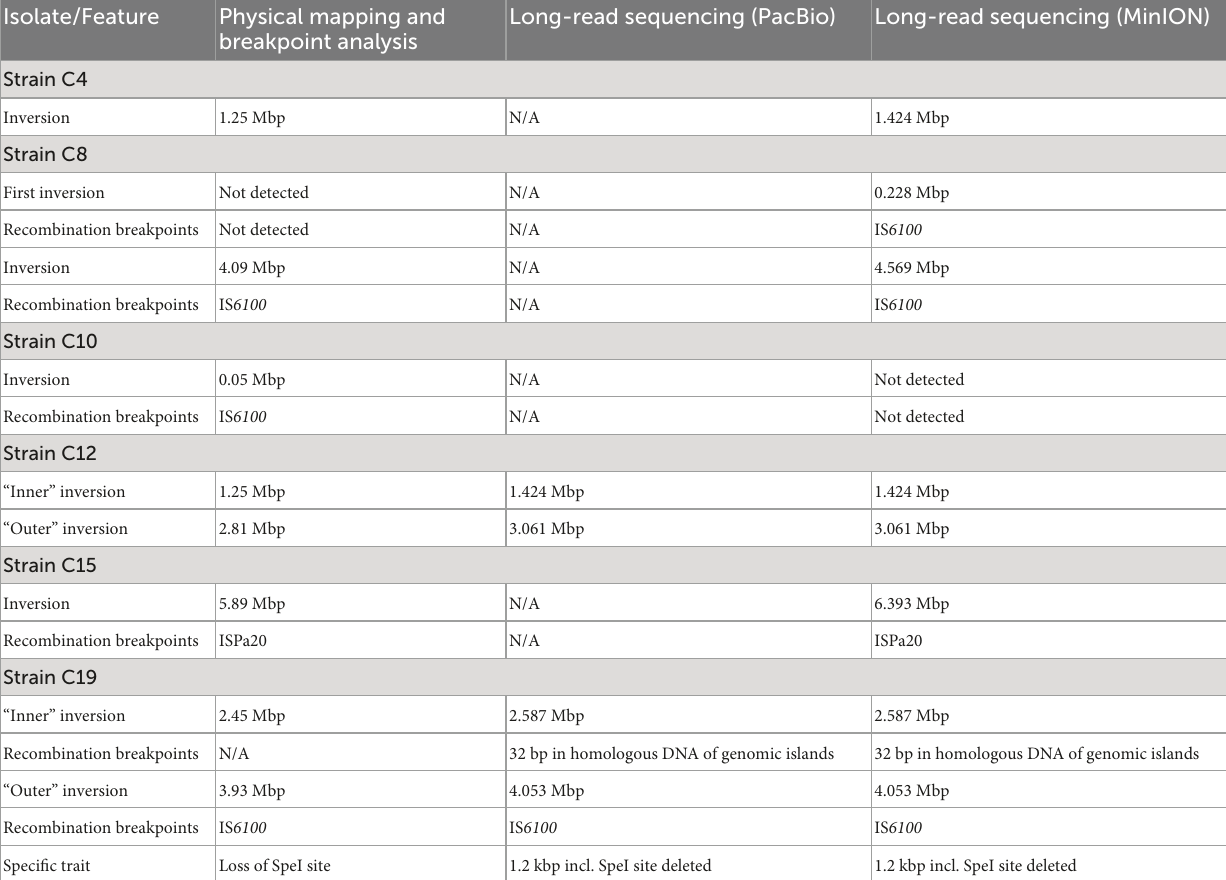
TABLE 5 Comparison of inversion characteristics resolved by physical genome mapping (Römling et al., 1997a), breakpoint-spanning amplicons (Kresse et al., 2003, 2006), and long-read sequencing (this